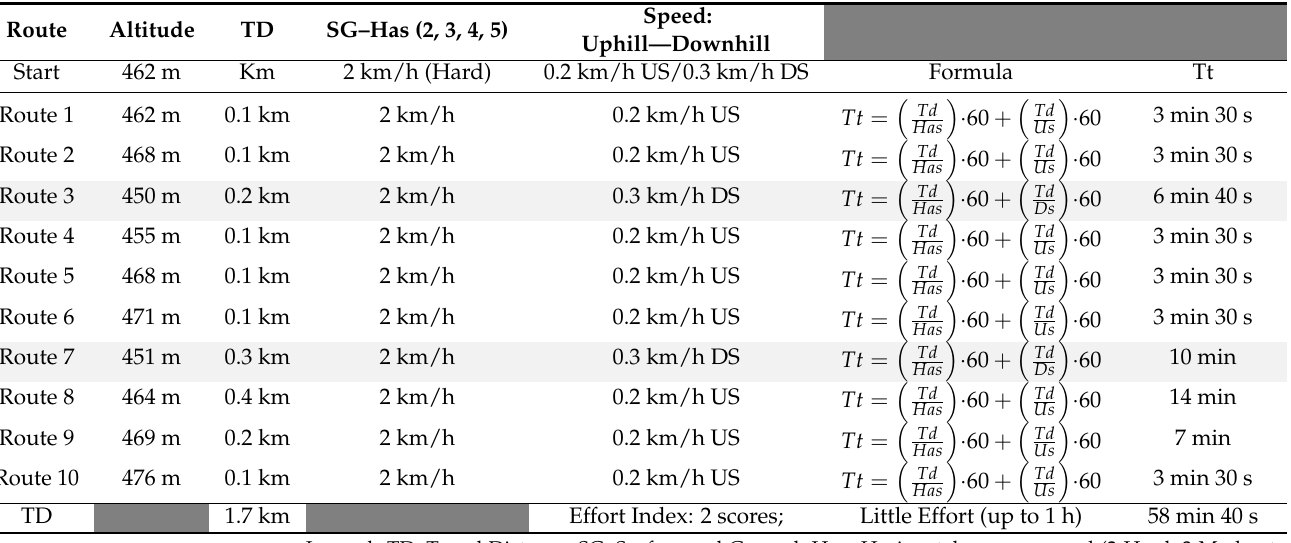
Table 7. Effort Index Classification by route and total of the S í tio Fund ã o trail; Araripe